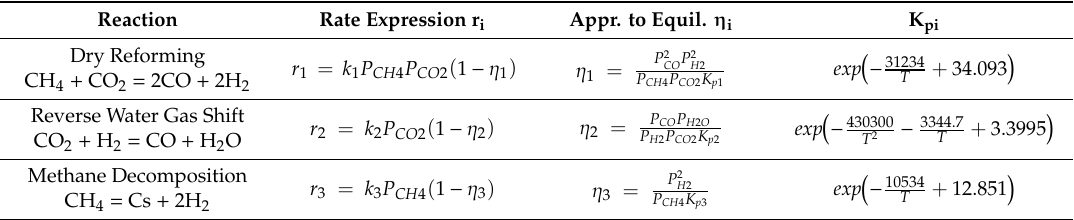
Table 3. Global kinetic engineering model with primary dry reforming (DR) and secondary reverse water gas shift (RWGS), methane decomposition (MD) reactions.